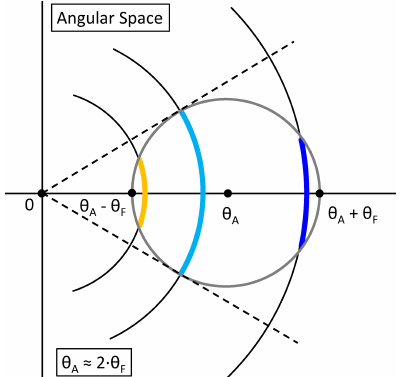
Figure 12. Illustration of FPI operation with an angle of incidence θ A and a field of view θ F in angular space, with 0 denoting the prime optical axis of the system defined as the normal to the FPI plates. The FPI circular interference fringes (black rings) are cen- tered at 0, but only portions of the fringes will be illuminated due to the off-axis centered aperture (gray circle) as indicated by the orange, light-blue, and dark-blue circular arcs. The dashed lines ex- emplarily mark the crossing points of the second interference fringe with the aperture or rather the fraction of the second interference fringe that is transmitted through the aperture (light-blue circular arc). The detailed analysis leading to Eqs. (14) to (19) and to the dispersion curves shown in Fig. 13 is based on the principle demon- strated here as it is also applicable for the dependence of the zero- order spot imaged on the Aeolus